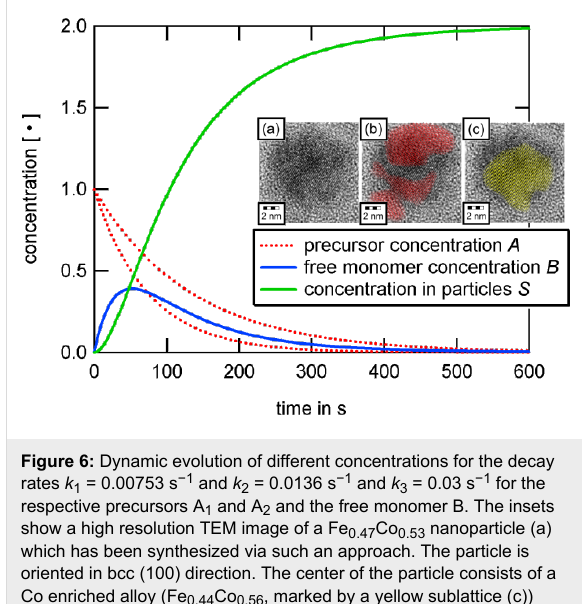
Figure 6: Dynamic evolution of different concentrations for the decay rates k 1 = 0.00753 s − 1 and k 2 = 0.0136 s − 1 and k 3 = 0.03 s − 1 for the respective precursors A 1 and A 2 and the free monomer B. The insets show a high resolution TEM image of a Fe 0.47 Co 0.53 nanoparticle (a) which has been synthesized via such an approach. The particle is oriented in bcc (100) direction. The center of the particle consists of a Co enriched alloy (Fe 0.44 Co 0.56 , marked by a yellow sublattice (c)) while the surface shows a higher Fe content (Fe 0.63 Co 0.37 , red lattice